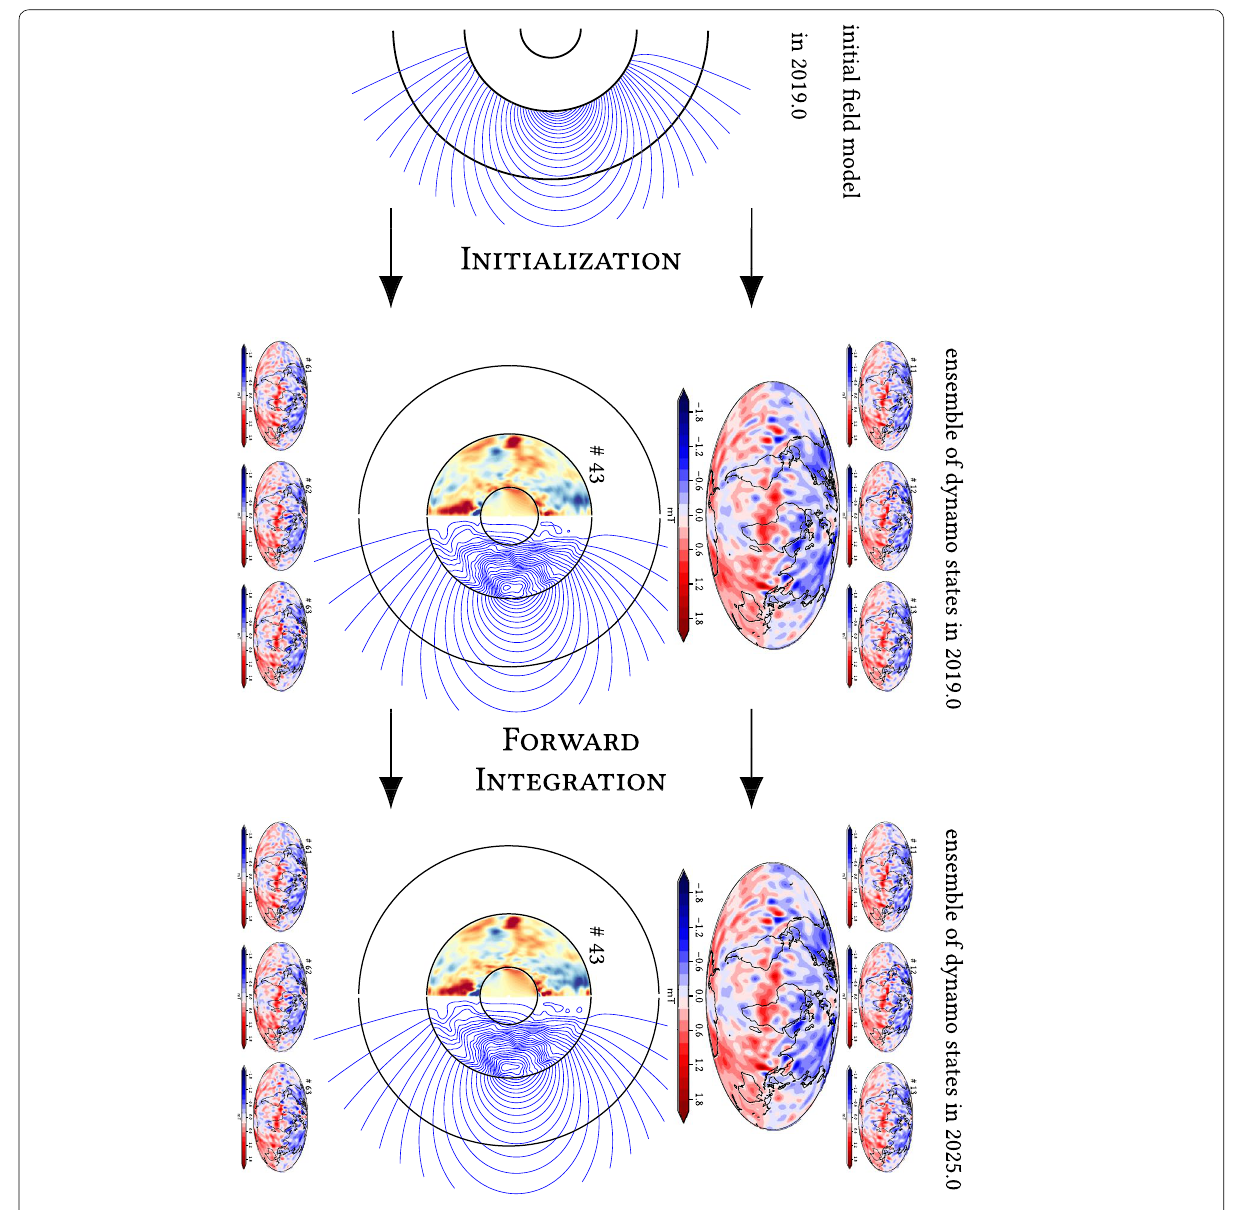
Fig. 2 A sketch of our workflow. Left panel: the initial magnetic field model for epoch 2019.0 B obs is estimated based on one year of Swarm data. This panel shows field lines of the axisymmetric meridional component of B obs . The thick black lines correspond to the Earth’s surface, the core–mantle boundary and the inner-core boundary. Middle panel: the information on B obs is used together with the statistics of the coupled Earth dynamo model to estimate an ensemble of dynamo states for 2019.0. Shown is the radial magnetic field at the core–mantle boundary for a few members of the ensemble, with a zoom on ensemble member 43. For this ensemble member, an additional meridional slice comprises the axisymmetric meridional field lines on the right, and the axisymmetric toroidal field inside the core on the left, with a scale ranging from − 2 mT (red) to + 2 mT (blue). Right panel: each dynamo state is advanced in time until 2025.0. The 100 trajectories so obtained are used to estimate the average secular variation between 2020.0 and